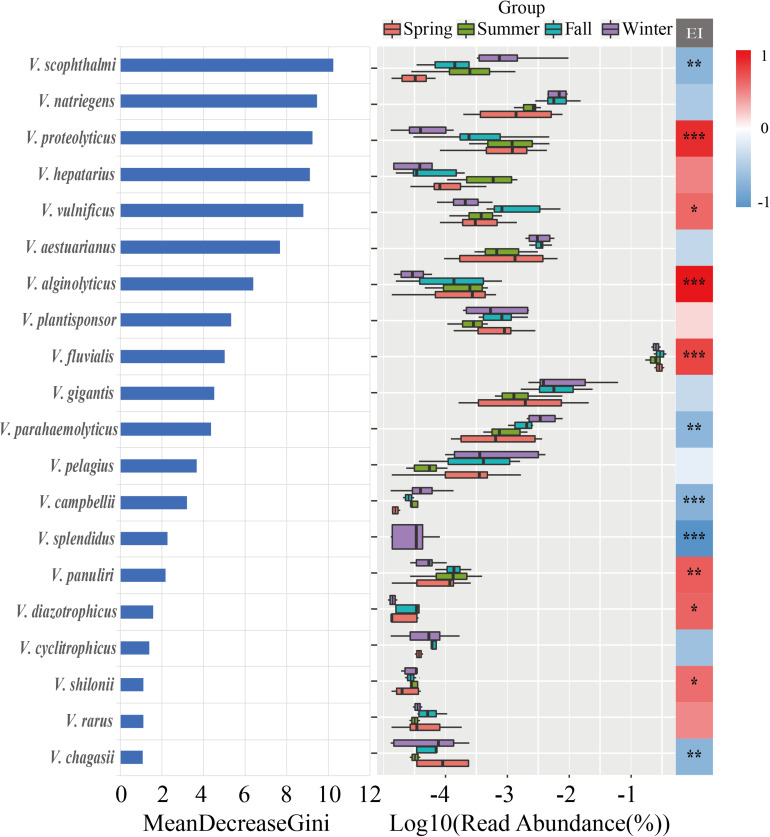
The random forest analysis of the top 20 important Vibrio species, ranked by Gini index. Middle: ranked by the richness of the top 20 Vibrio species with boxplot. Right: the correlations between the abundances of top 20 Vibrio species and EI variable by Spearman correlation analysis. *p < 0.05; **p < 0.01; ***p < 0.001.